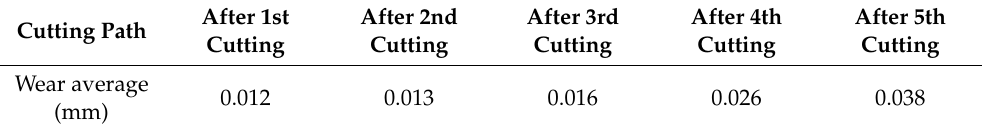
Figure 7. Change in frequency response of AE signals for the increase in tool wear: ( a ) signals on spindle; ( b ) signals on workpiece. Table 4. Flank wear level after cutting.